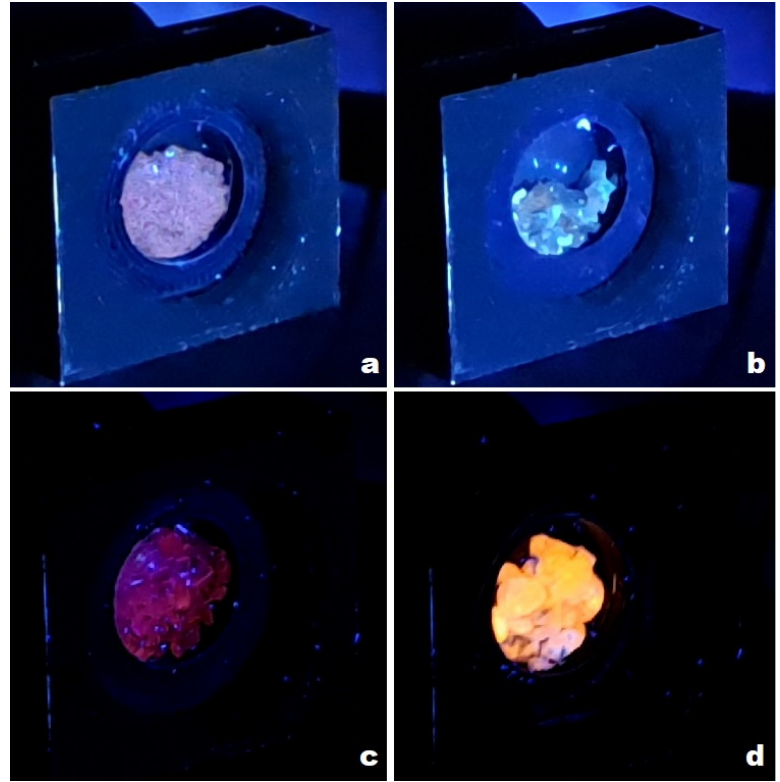
Figure 6. Luminescence color of ( a ) fluorapatite; ( b ) nepheline; ( c ) calcite; ( d ) sodalite.